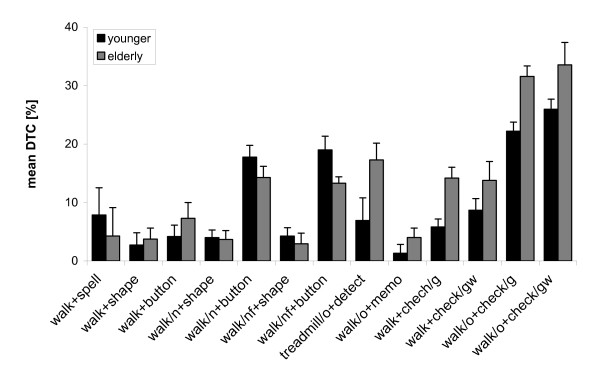
Mean dual-task costs of all task combinations in our present and previous study. [31]. Each bar represents the average score of younger (black) or older (grey) subjects, and each pair of bars one task combination. Error indicators are 20% of the corresponding standard deviation. An age-related deficit of dual-task performance exists where grey bars are larger than black bars.